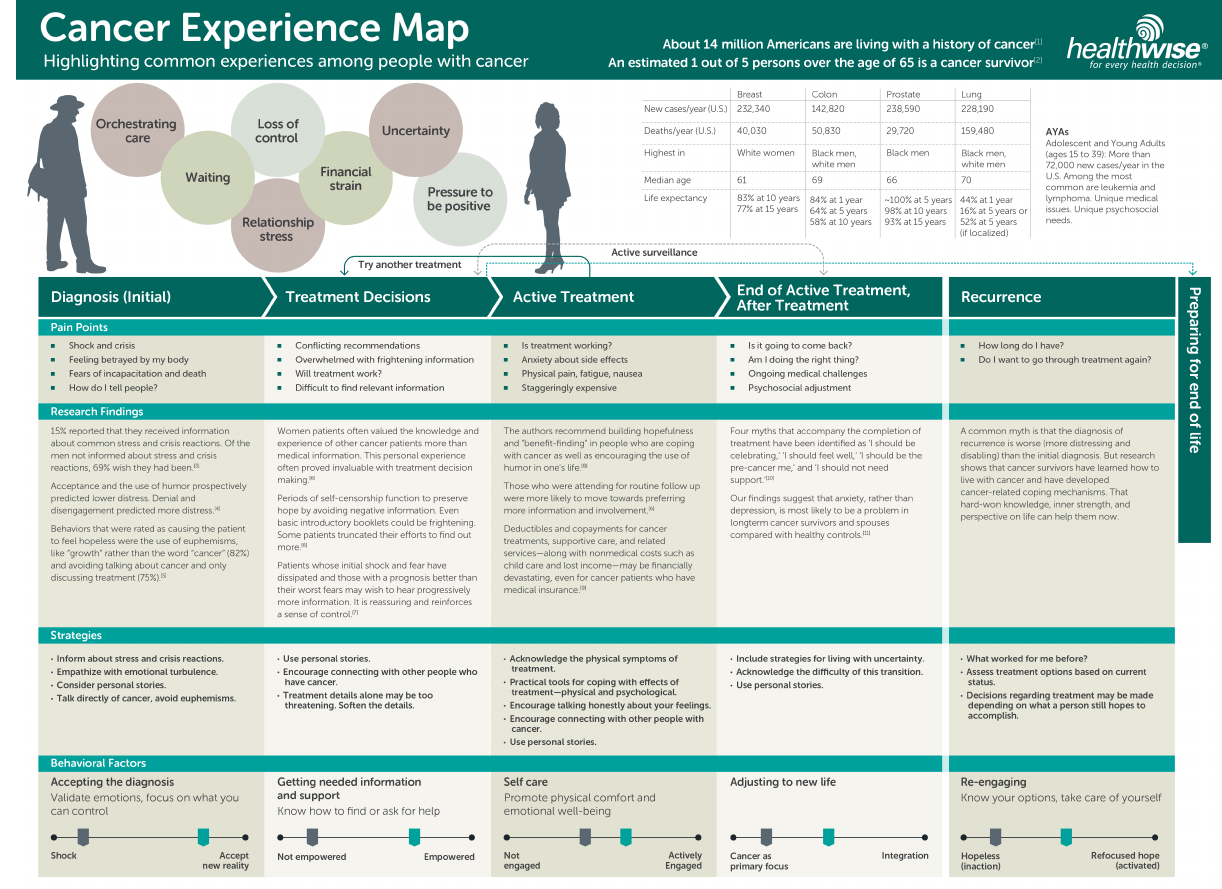
Figure 1. Cancer experience map (see Multimedia Appendix